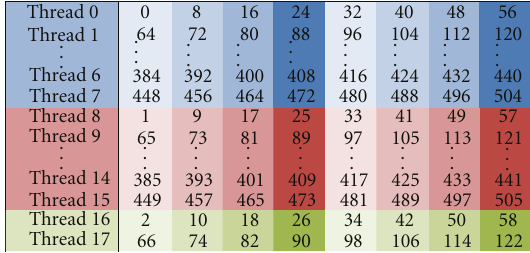
Just as the first 3 stages could be grouped to form a single 8-point FFT, the next group of 3 butterfly stages could be grouped, if the correct data was selected. Using this method, shared memory only needed to be accessed after the 3rd and 6th set of butterfly stages. A Decimation-In-Frequency